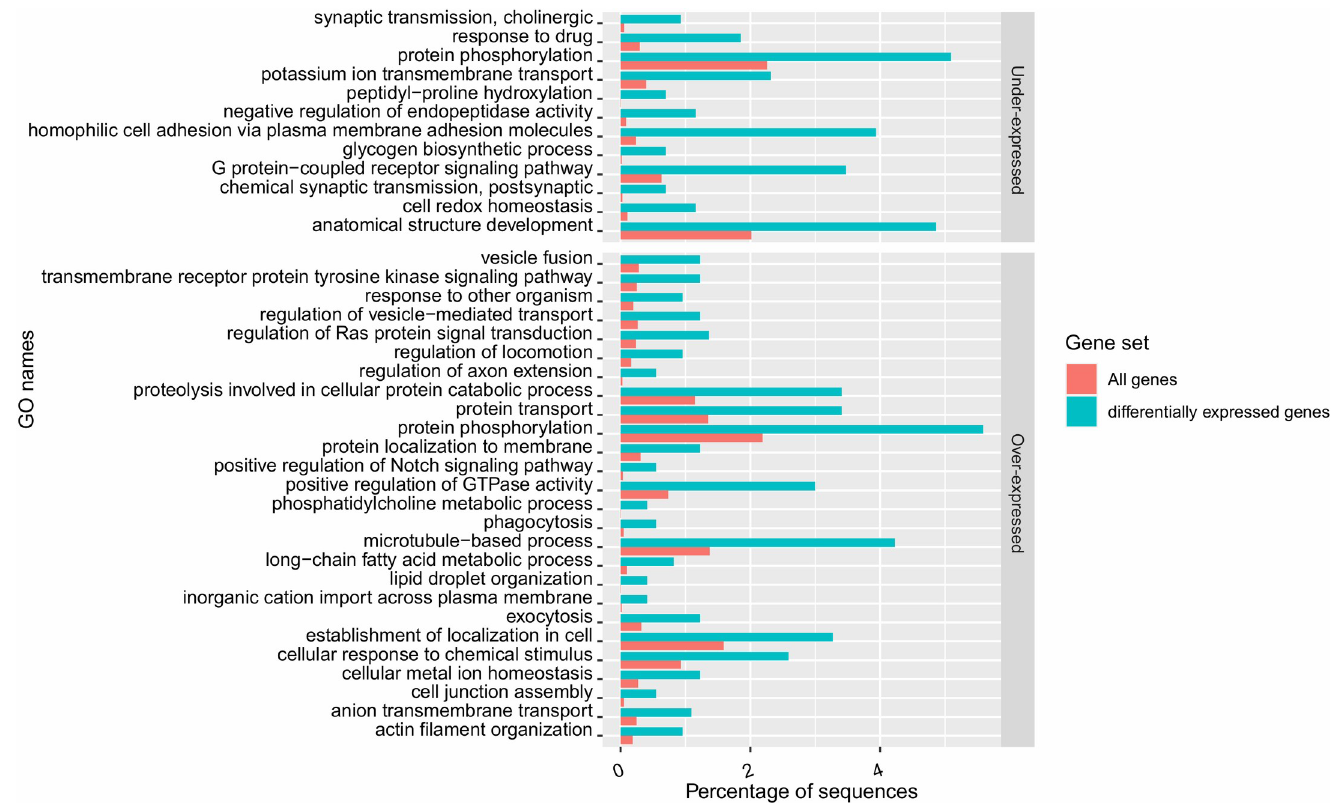
Fig 5. Biological processes impacted by hetero-specific pairing in male S . haematobium . Barplot showing the biological processes significantly enriched in DEGs (at a FDR threshold of 5%), either over-expressed or under-expressed in hetero-specific condition compared to homo-specific condition, in S . haematobium